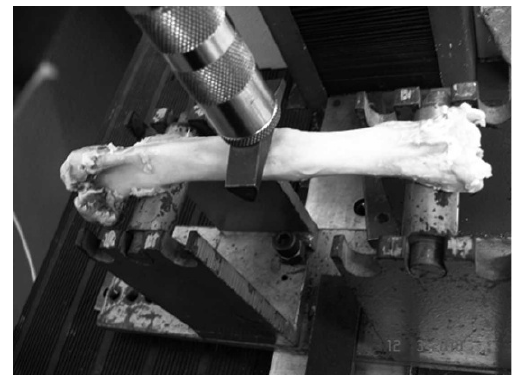
Figure 3 - Photograph of a biomechanical assay. The operated tibia (linear osteotomy) was positioned on the two rounded stands and the load was applied via the rounded wedge-shaped accessory that was placed directly on the healed osteotomy site.